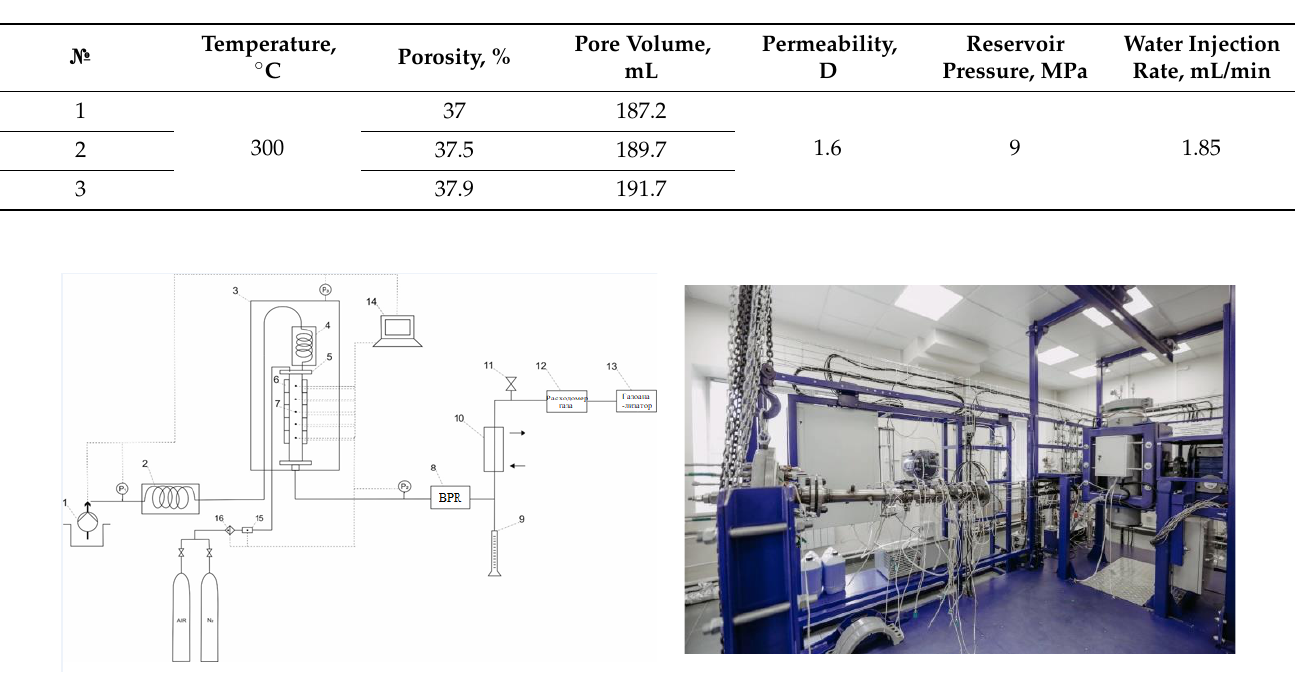
Table 7. Conditions of experiments.